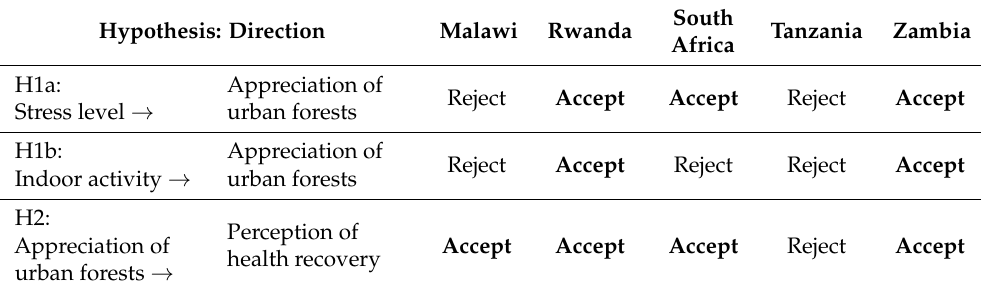
Table 7. Research hypotheses tested by SEM model fit.